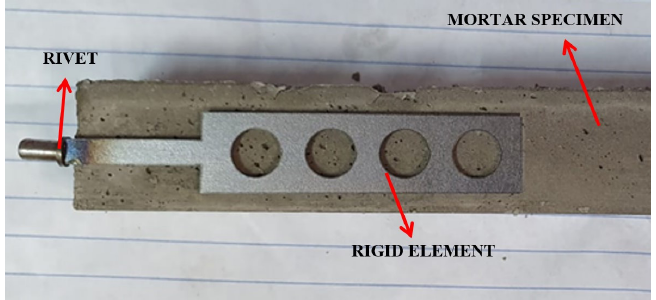
Figure 6. Overlay of the rigid element on the sample to demonstrate its position internally.